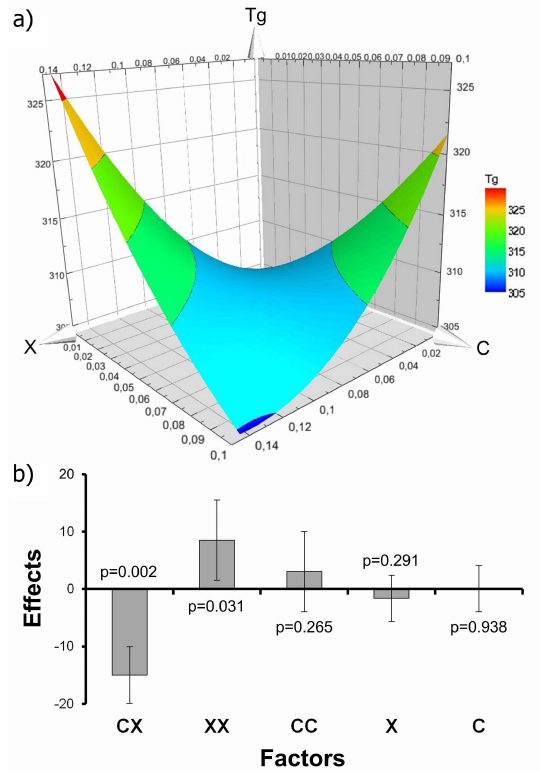
Figure 2. Results of the experimental design analysis for glass transition. ( a ) Surface plot for T g as a function of C and X . ( b ) Effects plots (with p -values and error bars 95%) for T g